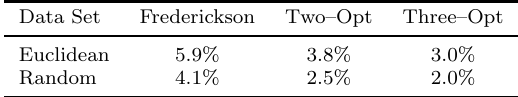
Table 3: Average percentage–gap–over–lower bound values obtained by the RPP heuristics on the test problem instances of Table 2.